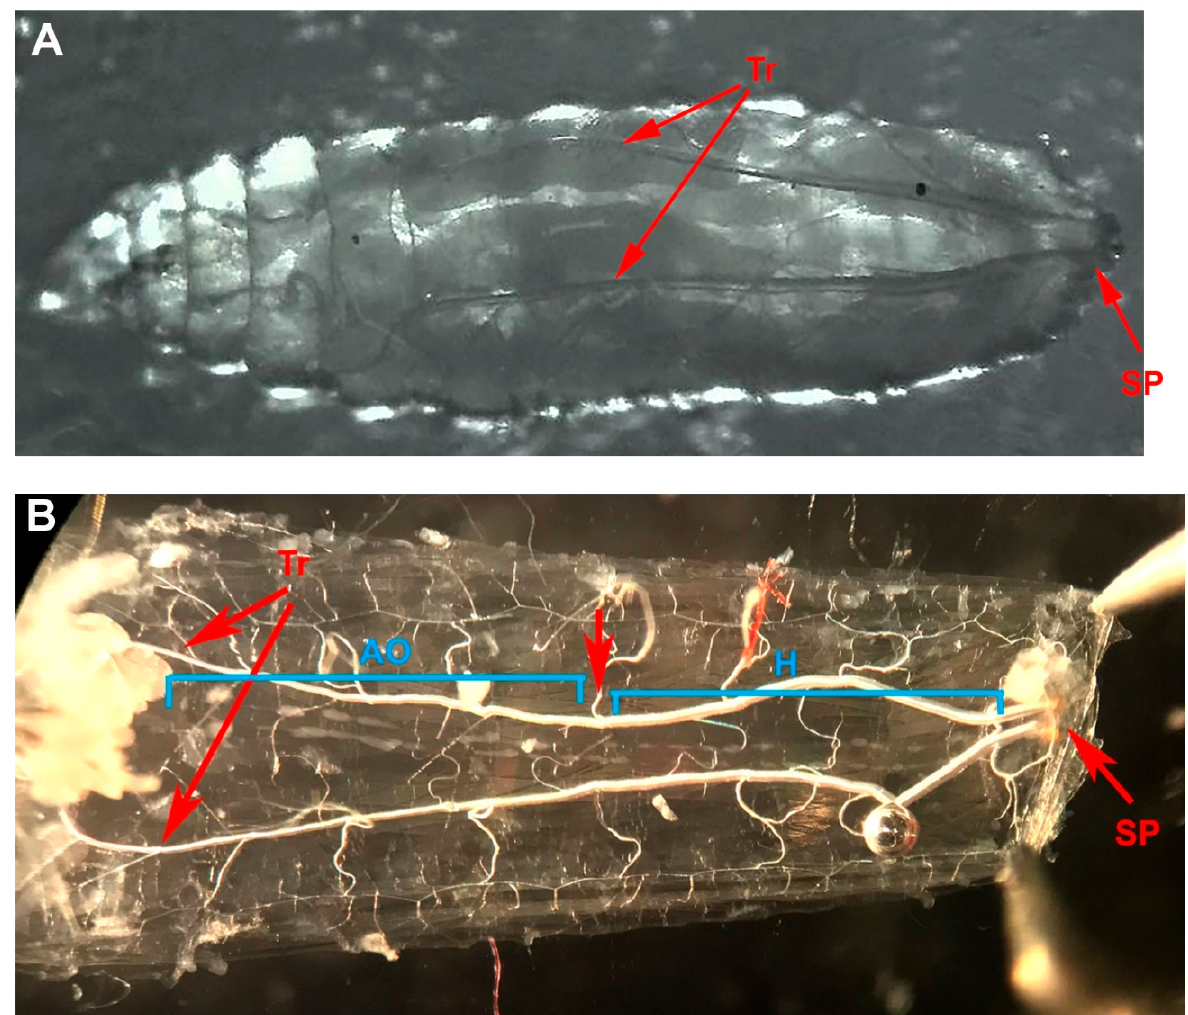
Figure 1. Larval heart tube in a third instar. ( A ) Whole larva is stuck to double-stick tape on a glass slide to observe heart beats with light shining from below. Dorsal view is shown and the heart tube is between the two tracheal tubes. ( B ) The animal is pinned with the dorsal side down. The heart tube is between the two trachea (Tr) running the length of the larvae. The spiracles (SP) are seen on the caudal end. The heart tube has the region of the true heart (H) where the heart generates the electrical rhythm and the aorta (AO) to direct hemolymph toward the head. The preparation is bathed in physiological saline.